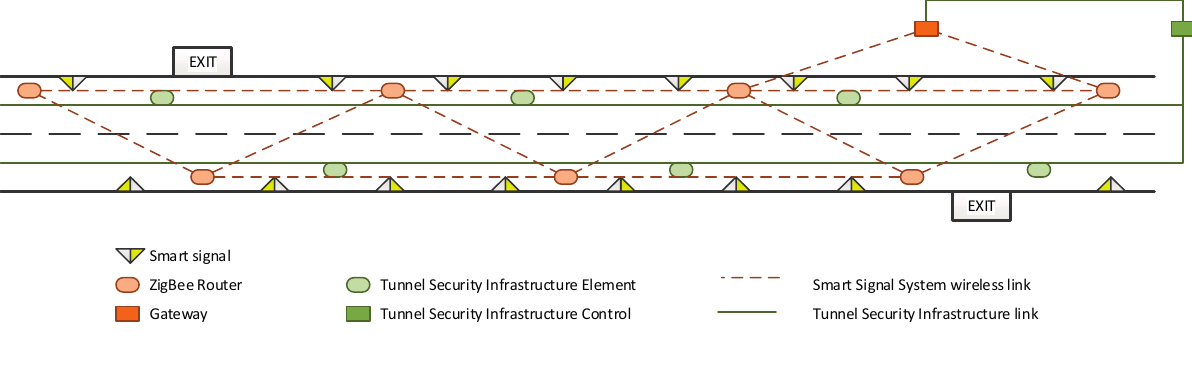
Figure 8. Smart Signal System infrastructure.